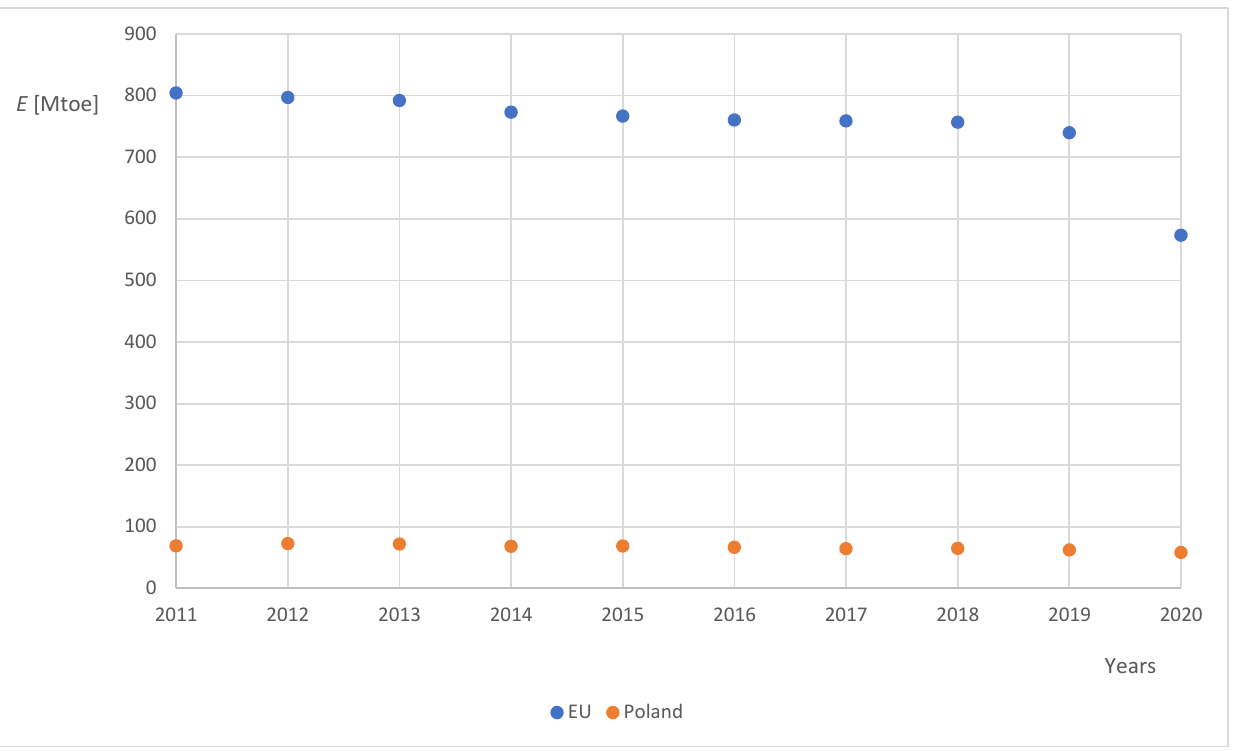
Figure 3. Total primary energy production in the EU and Poland, according to Table 18 (own elab- oration).